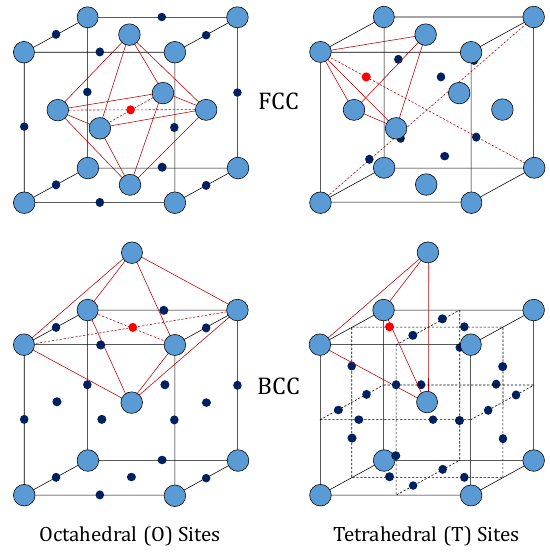
Figure 1. Octahedral (O) and Tetrahedral (T) sites in FCC lattice and BCC lattice [13].